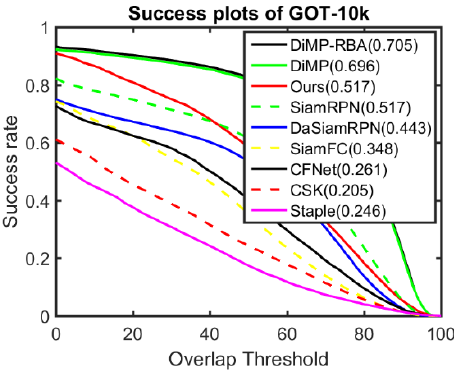
Figure 9. Comparison between the proposed method and baseline trackers on the OTB100 bench- mark: ( a ) precision plots; ( b ) success plots.